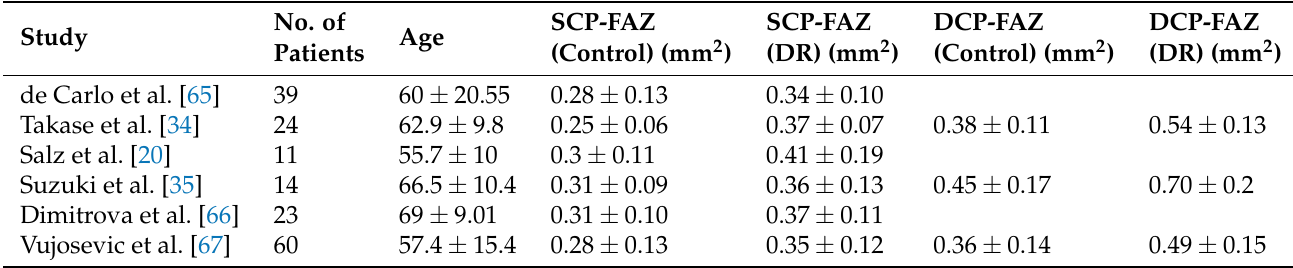
Table 3. Average areas of FAZ in normal and early DR cases.